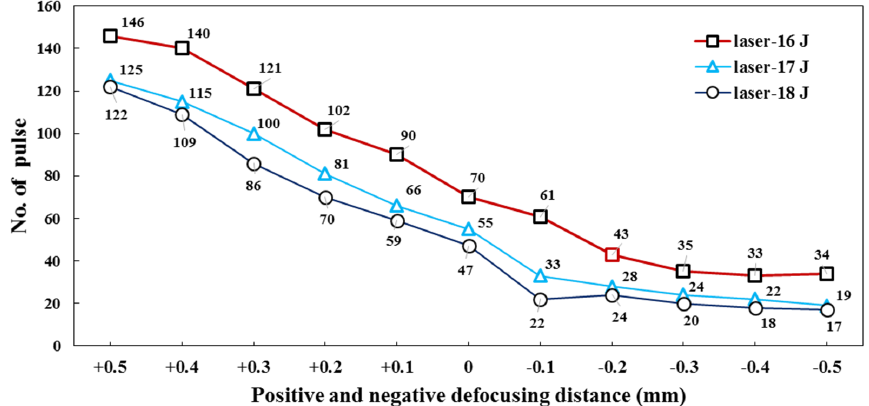
Figure 14. Relationship between positive and negative defocusing distance and pulse number for perforation.